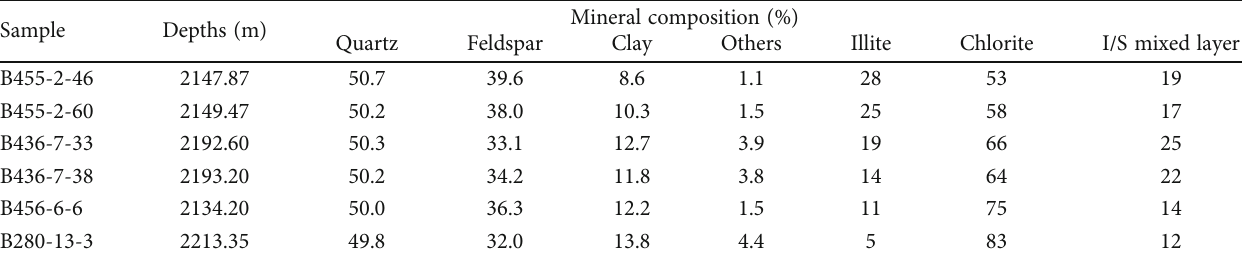
Table 1: Sample information and rock mineral composition of Chang 8 reservoir.